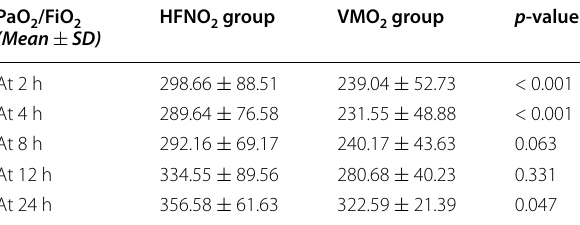
/FiO is significantly higher in the HFNO 2 2